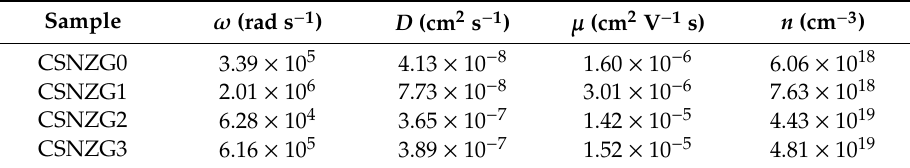
Table 4. The ω , D , µ , and n values at room